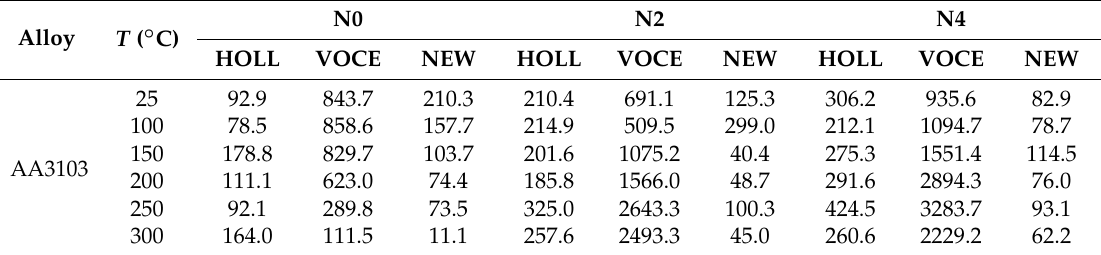
Table 14. Error of each flow rule obtained for AA3103 in relation to the experimental curve (N). Alloy T (°C)